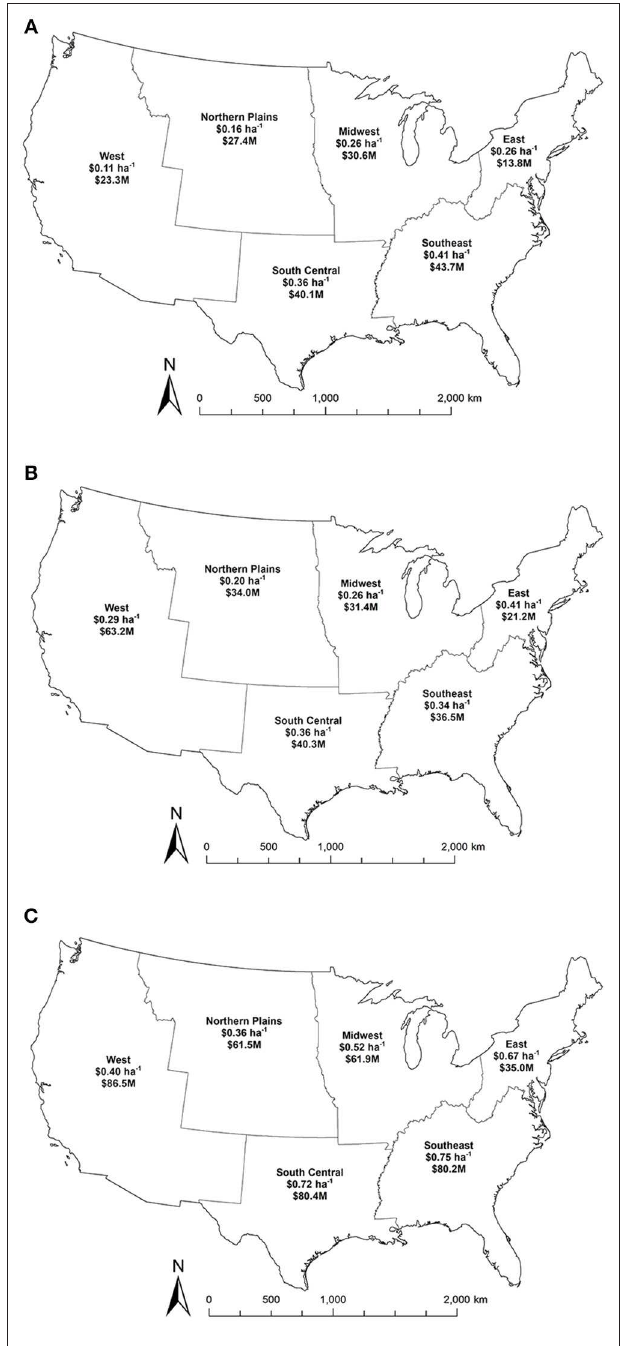
FIGURE 4 | Area-normalized value of annual K + deposition ($/ha, top number), and value of total storage ($, bottom number) and for different regions in the contiguous United States based on a moving 5-year average price of U.S. $500 per metric ton of potassium chloride (KCl) (Yager, 2016): (A) wet, (B) dry, and (C) total.